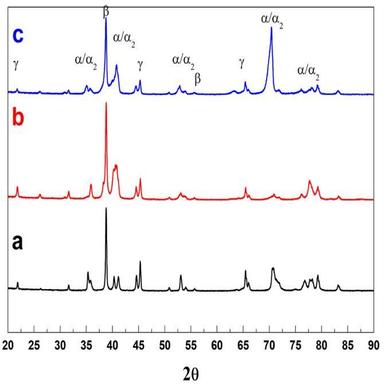
XRD patterns of the cross-section (YZ plane) of the 0.5, 1, and 2 mm overlap specimens: (a) 0.5 mm, (b) 1.0 mm and (c) 2.0 mm.